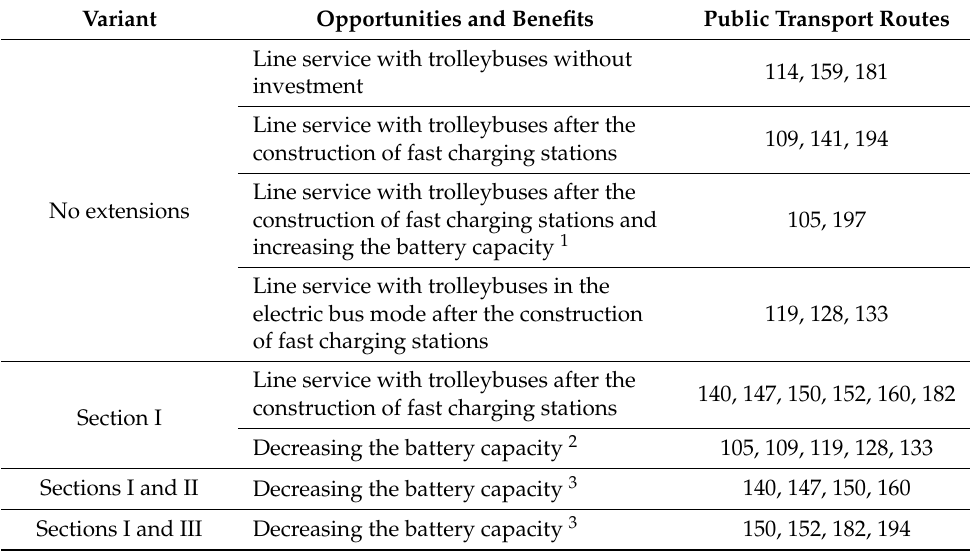
Table 3. Investment variants related to the development of trolleybus transport in Gdynia (source: own